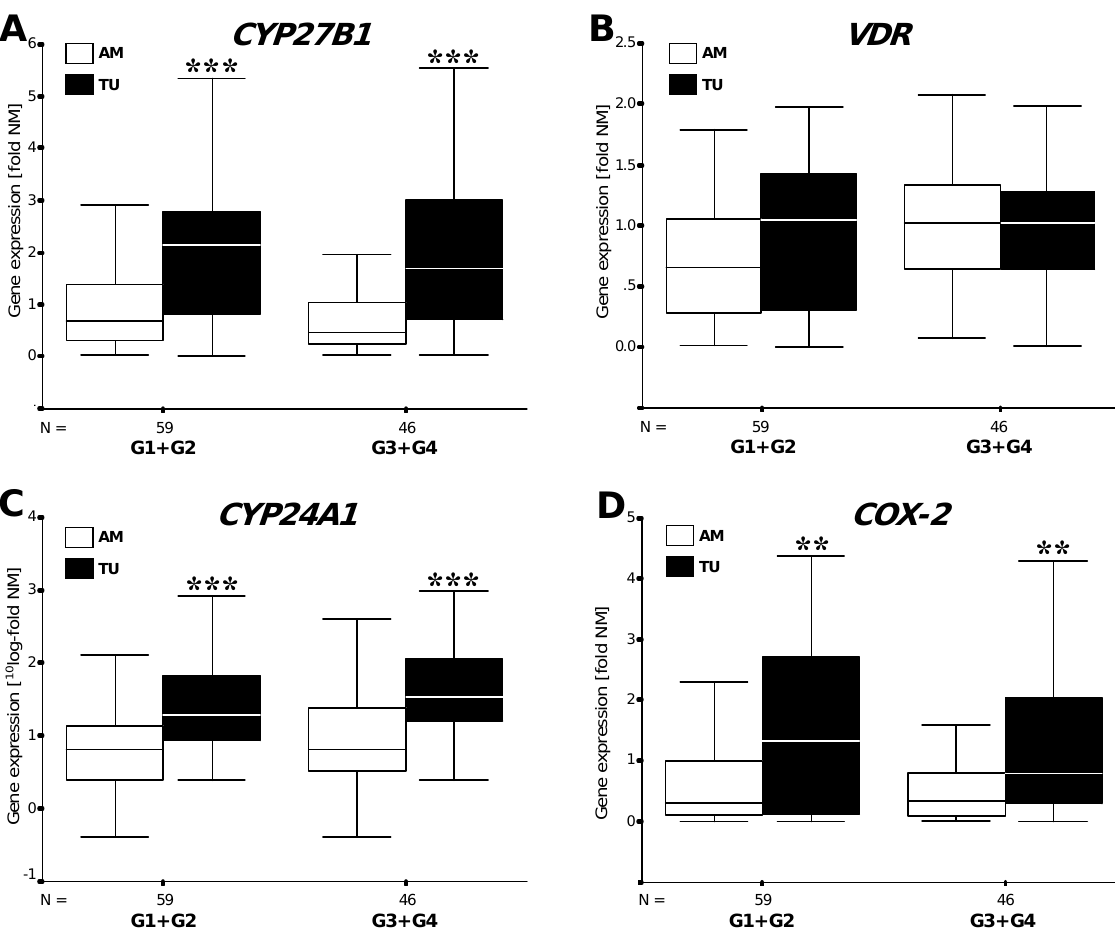
Figure 2. mRNA expression of CYP27B1 ( A ), VDR ( B ), CYP24A1 ( C ) and COX-2 ( D ) in cancerous colorectal mucosa (TU) at different stages of malignancy (G1–G4) and in paired tumor-adjacent mucosa (AM). Results of semi-quantitative PCR (see Methods) are shown as boxplots of medians from n patients per group. Expression levels in normal mucosa of non-cancer patients were set to 1 for external reference (see [2]). Note that data in Figure 2C are shown on a logarithmic scale. Asterisks indicate statistically significant difference at **, p < 0.01; ***, p <